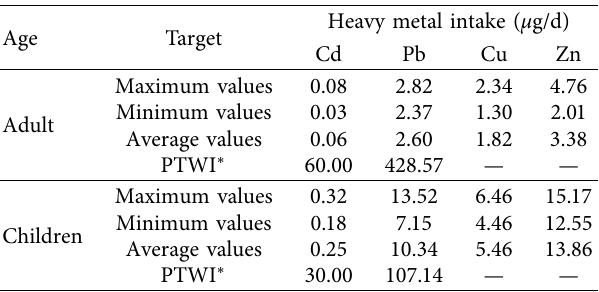
Table 5: Amount of heavy metals ingested by adults and children through the soil-human